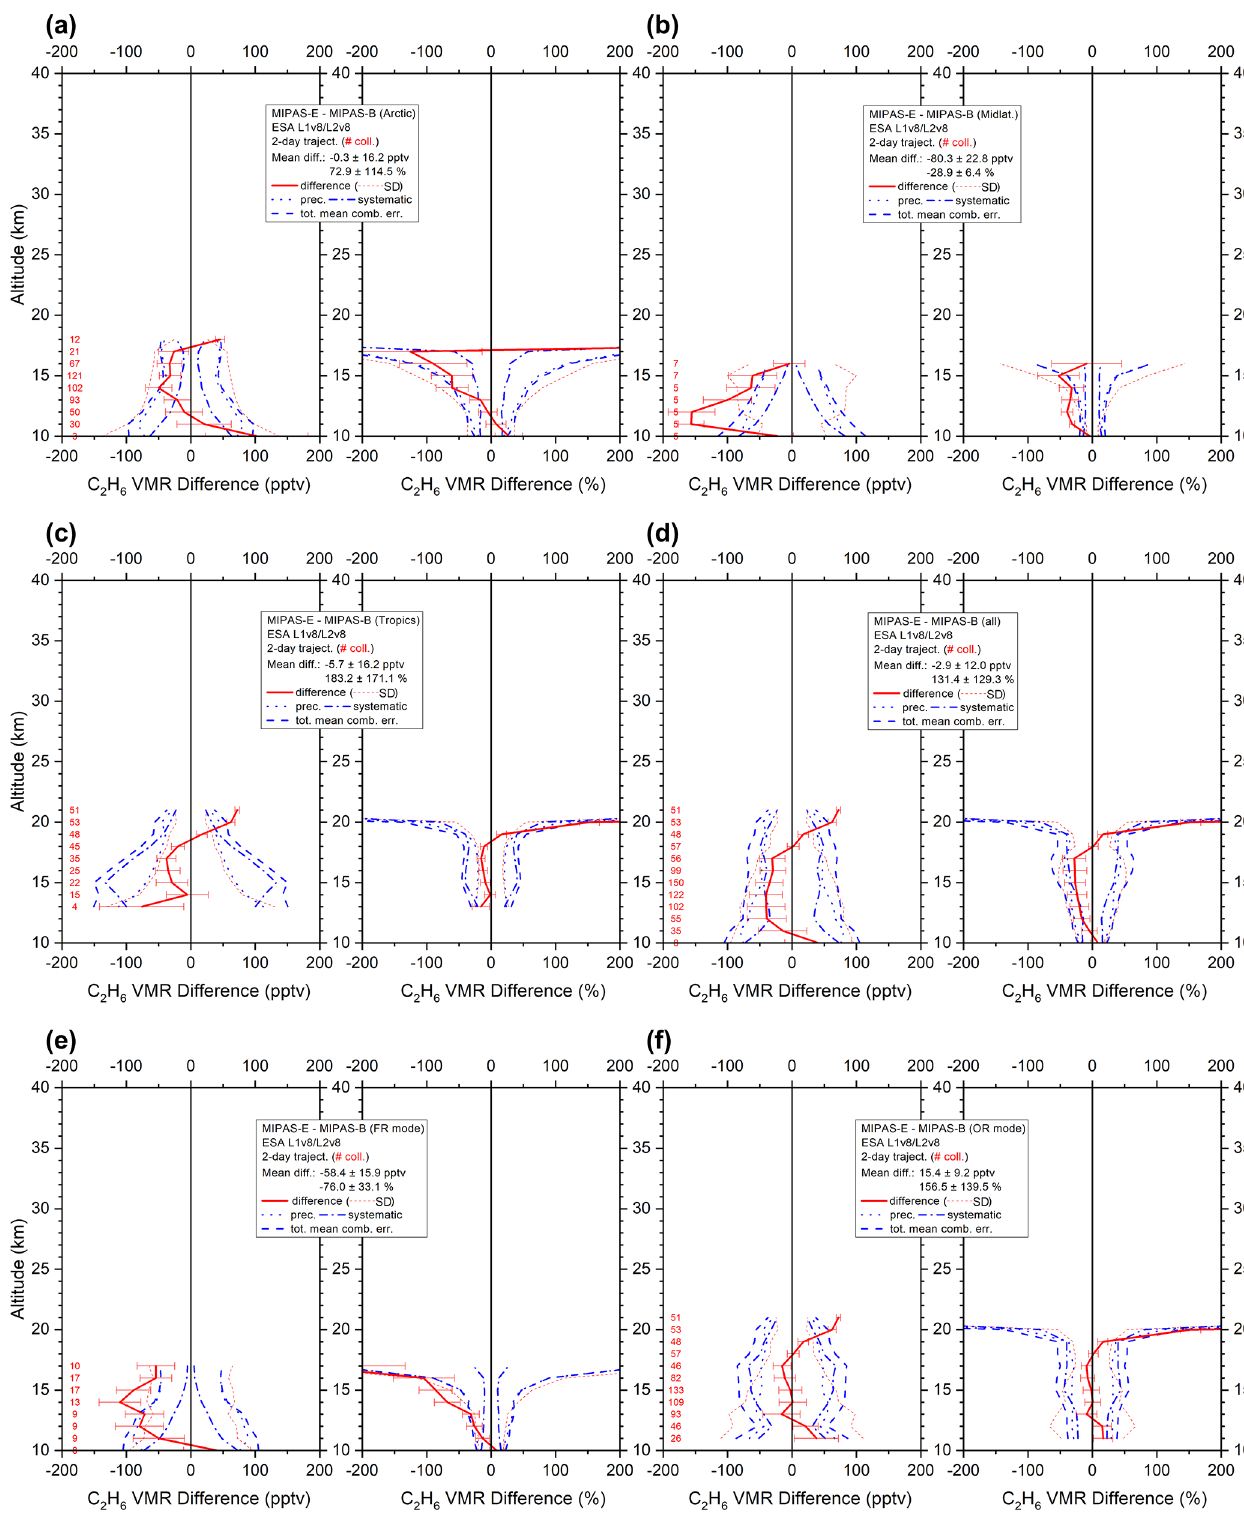
Figure 19. Same as Fig. 3 but for C 2 H 6